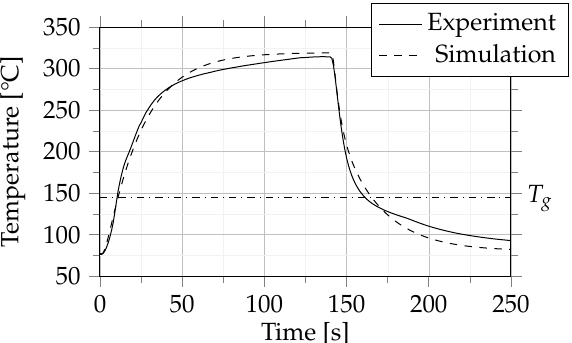
Figure 10. Case 1: Comparison between experiment and simulation in terms of temperature be- haviour of the composite. The dash-dotted line indicates the glass transition temperature ( T g ) of 145